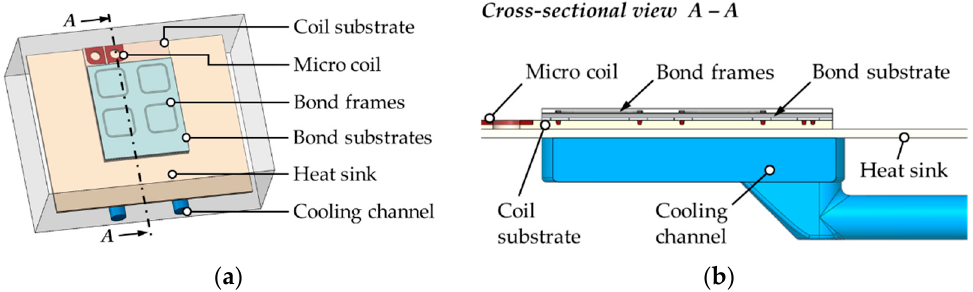
Figure 5. Simulation model with the major components: ( a ) Top view; ( b ) Cross-sectional view.